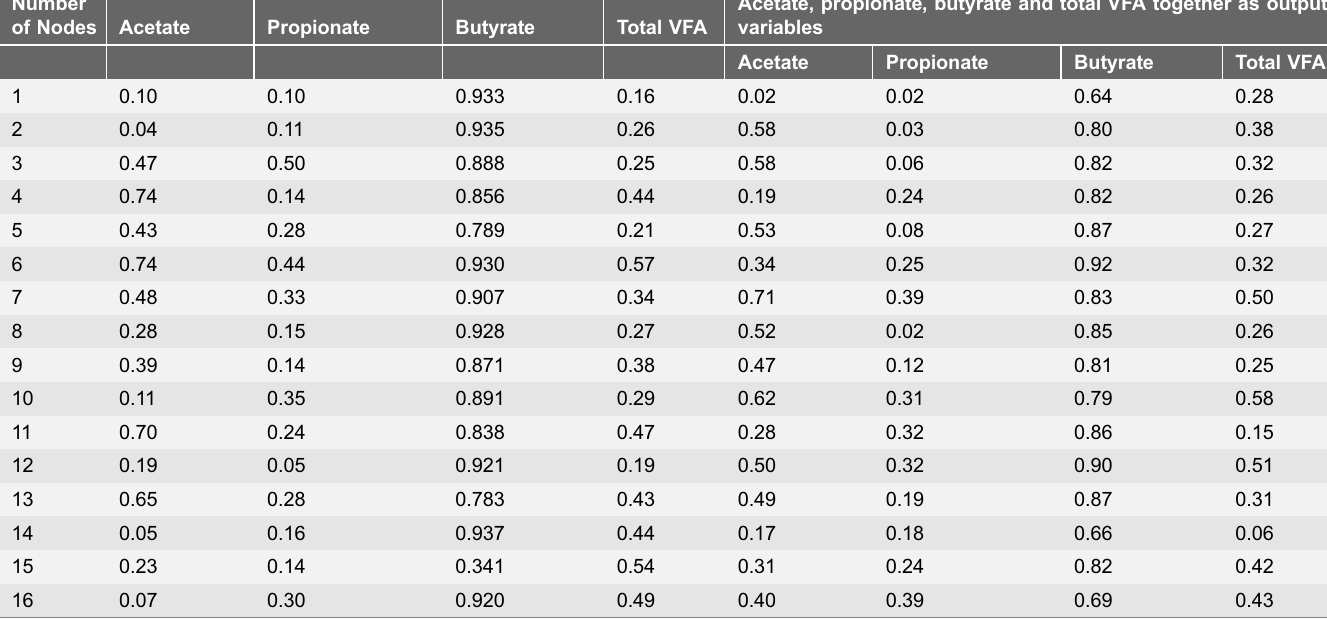
Table 6. The R 2 between the observed and the predicted values with different number of nodes in the hidden layer. Number of Nodes Acetate